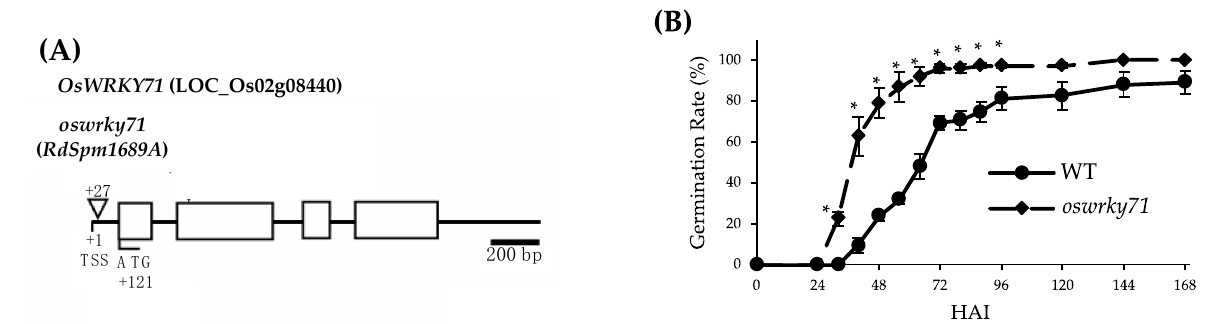
Figure 1. Mutant oswrky71 seeds display an early germination phenotype. ( A ) Gene diagram for OsWRKY71 showing the position of dSpm transposon insertions in oswrky71 . Transcriptional start site (TSS) and start codon (ATG) are marked. Boxes indicate exons. Triangles with arrows represent the position of each insert. The number of base pairs downstream from TSS is shown. Scale is 200 bp. ( B ) Quantification of germination rates for wild-type (WT) and oswrky71 mutant. Seeds were incubated at 28 ◦ C in the dark on 1 / 2 × MS plates (0.05% MES ( w / v ), pH = 5.8). Germination was defined as a radicle or coleoptile reaching approximately 2 mm in length. Error bars represent ± SEM. Asterisks indicate significance for one mutant relative to the wild type in Student’s t test ( p < 0.05). n = 3 biological replicates, each with 25 seeds.